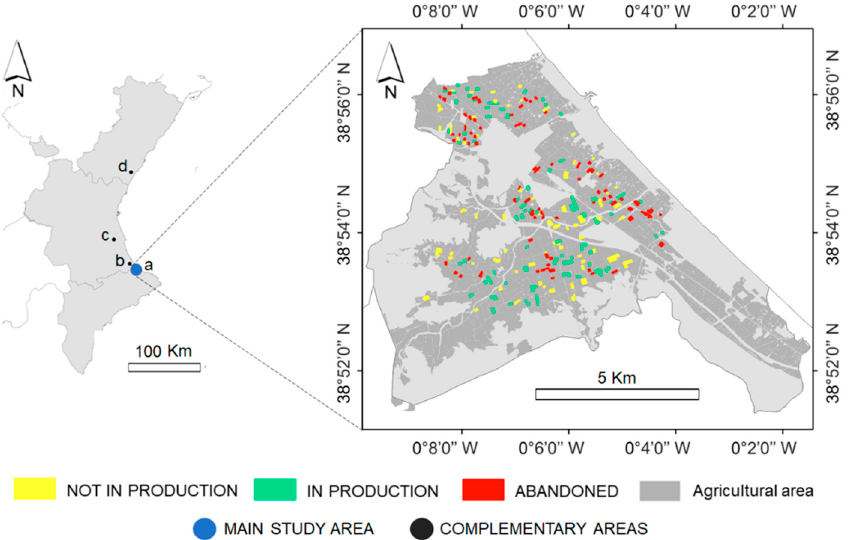
Figure 2. Study area. On the left the Comunitat Valenciana (CV) region and the study areas: ( a ) Oliva, ( b ) Bellreguard-Almoines, ( c ) Benicull-Polinyà del Xúquer and ( d ) Nules. On the right the main study area in Oliva municipality and the plots classified during the field survey.